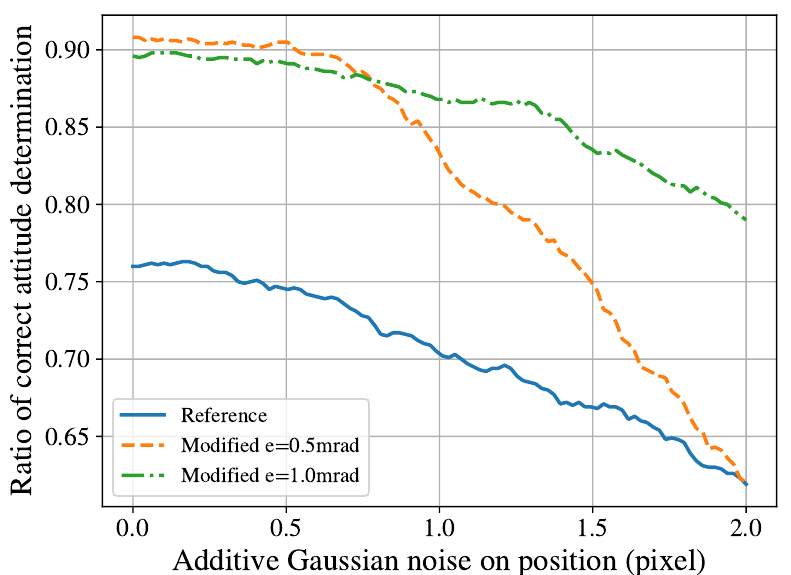
Figure 9. Effect of noise on the 2D position of stars on the performance of reference and modified algorithms. Here, a field of view of 8° is